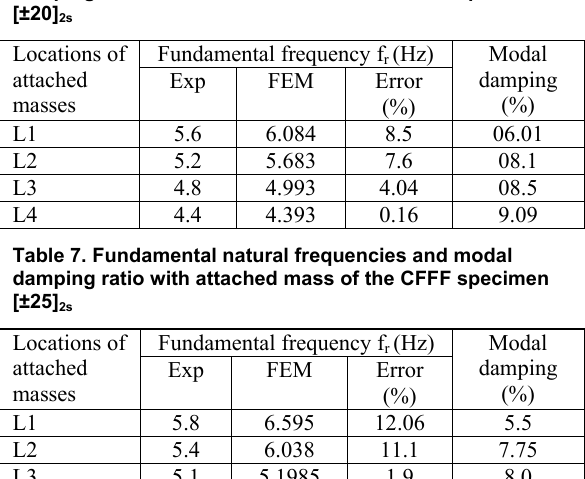
Table 6. Fundamental natural frequencies and modal damping ratio with attached mass of the CFFF specimen